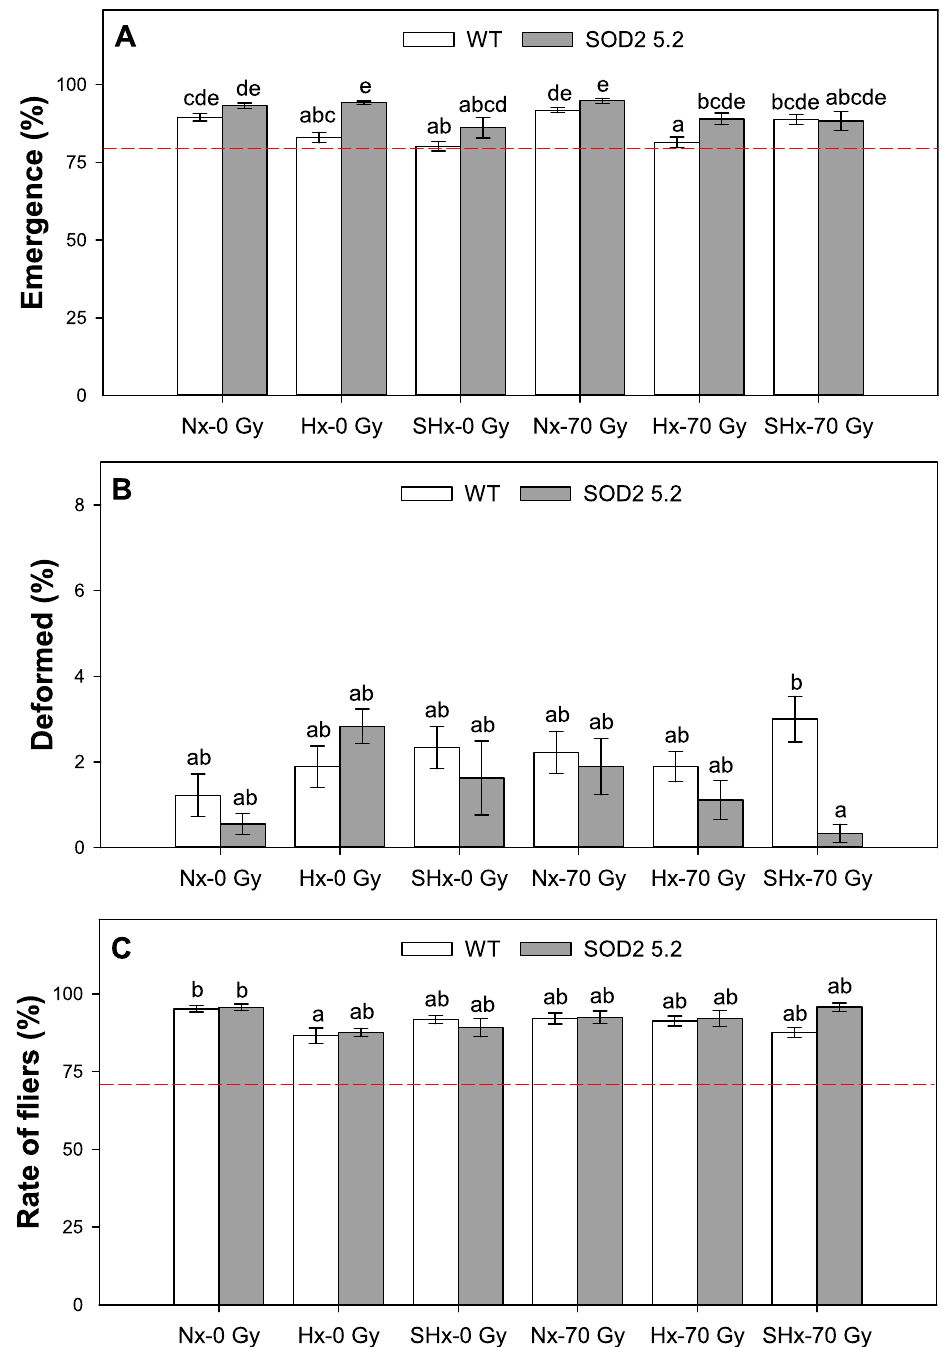
Figure 2. Quality control parameters assessed for non-irradiated and irradiated WT and SOD2 5.2 insects kept in normoxia (Nx) or treated with hypoxia (Hx) or severe hypoxia (SHx) conditioning for 1 h in the pharate adult stage. Percentage of adult emergence ( A ), deformed insects ( B ), and rate of fliers ( C ) were measured across treatments tested for each line. Graph bars represent means with standard errors for each treatment tested for both lines. Dashed red lines indicate 80% adult emergence in ( A ) and 70% fliers in ( C ), which are the minimum post-irradiation percentages acceptable for Anastrepha suspensa produced in SIT programs (FAO/IAEA/ USDA 2019 29 ). Bars followed by different letters are significantly different from each other (LS-means contrasts, P < 0.05). Figures were created using Sigma Plot (SigmaPlot for Windows version 14.0, Copyright 2017, Systat Software, Inc. Palo Alto, CA,